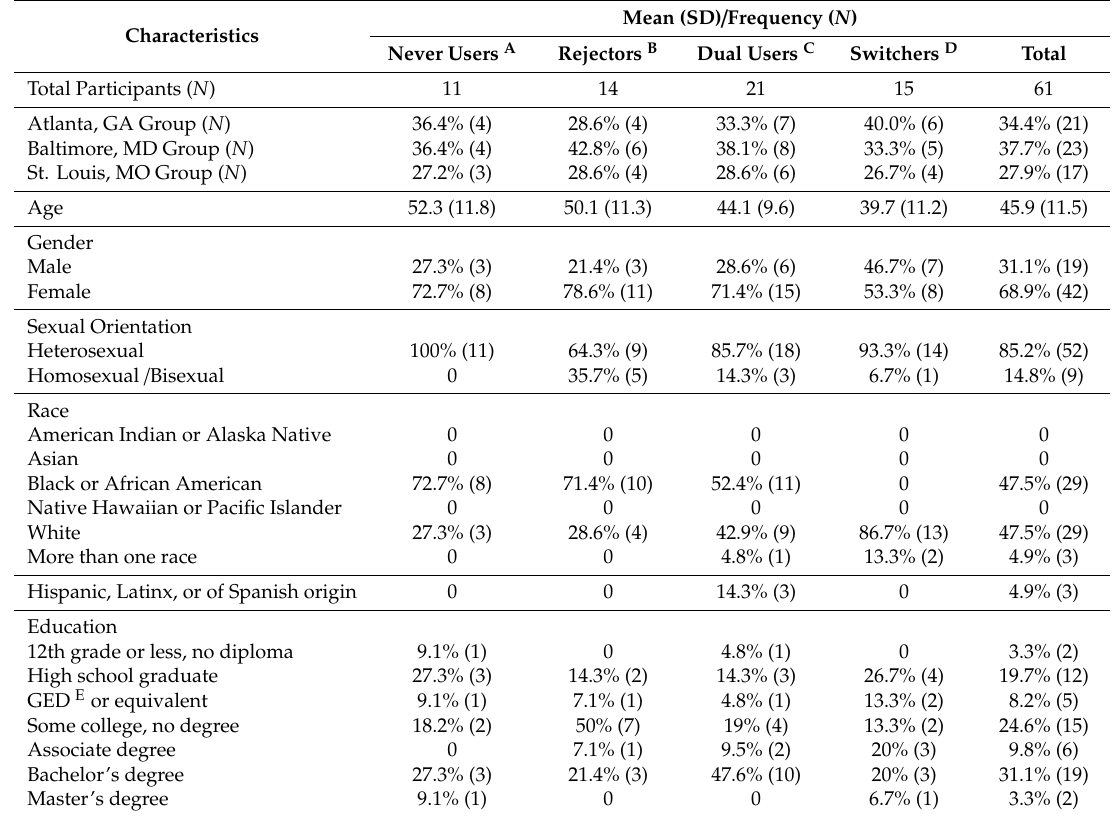
Table 1. Demographic information for study